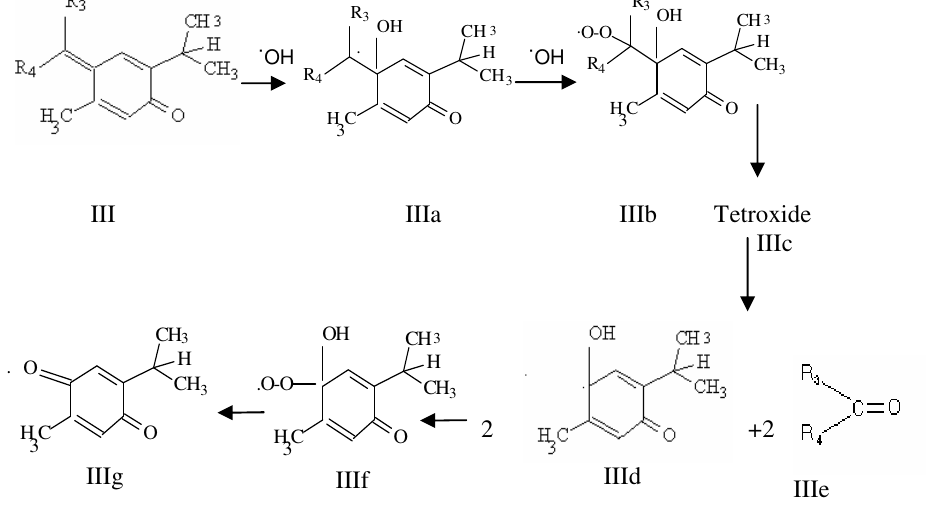
Figure 5 . The degradation route of the segment